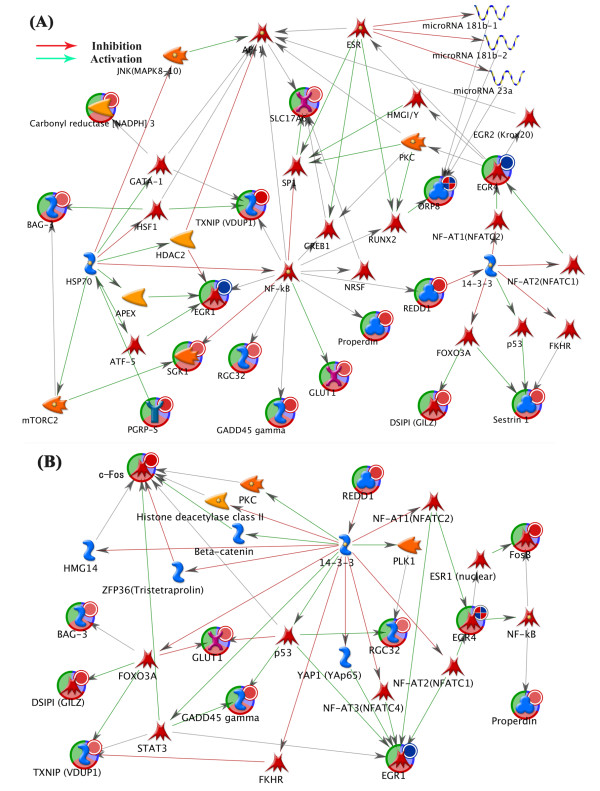
Network developed in MetaCore based on the genes listed in (A) Table 1and (B) Table 2. Interactions between nodes are shown by arrows, indicating activation (green), inhibition (red), and unspecified effects (gray). Detailed information on the symbols can be found at http://pathwaymaps.com/pdf/MC_legend.pdf (accessed July 7, 2013). A gene in the networks that contain a small circle was verified by quantitative reverse-transcription polymerase chain reaction. The small red circle indicates upregulation. The small blue circle indicates downregulation. The small mixed-color circle indicates positively and negatively regulated expression dependent on genotype.